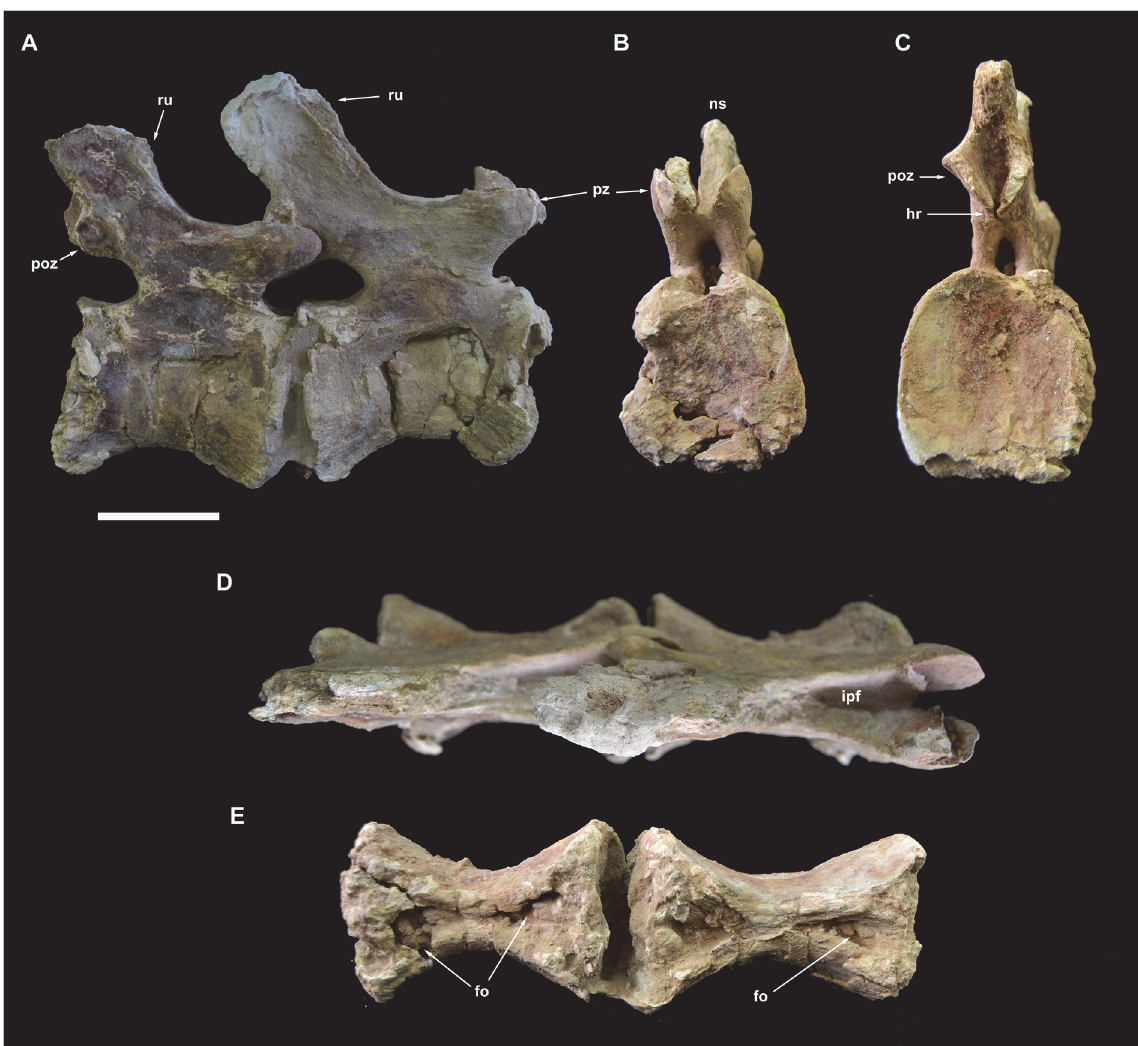
Fig 15. Caudal vertebrae 13 and 14 of Tataouinea hannibalis . Vertebrae in right lateral (A), proximal (B), distal (C), dorsal (D) and ventral (E) views. Scale bar: 10 cm. Abbreviations: fo, fossa; hr, hyposphenal ridge; ns, neural spine; poz, postzygapophysis; pz, prezygapophysis; ru, rugosities; sprf, spinoprezygapophyseal